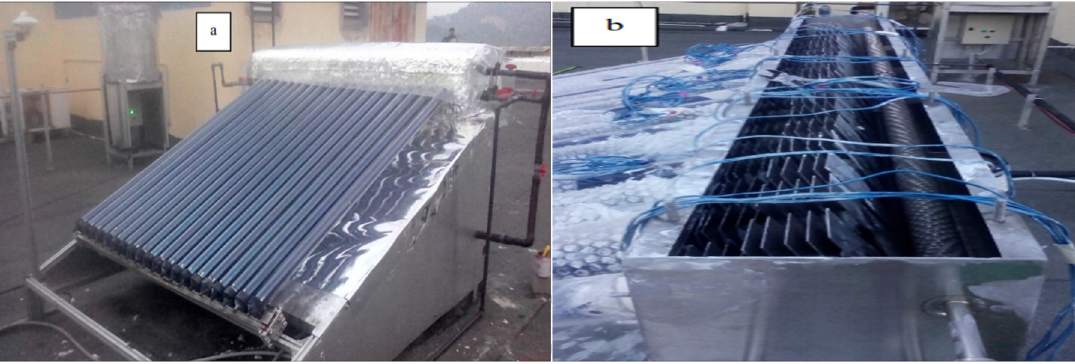
Figure 5. ( a ) ETHPSC-LHTES experimental system. ( b ) Photo of inside of the LHTES tank [19].